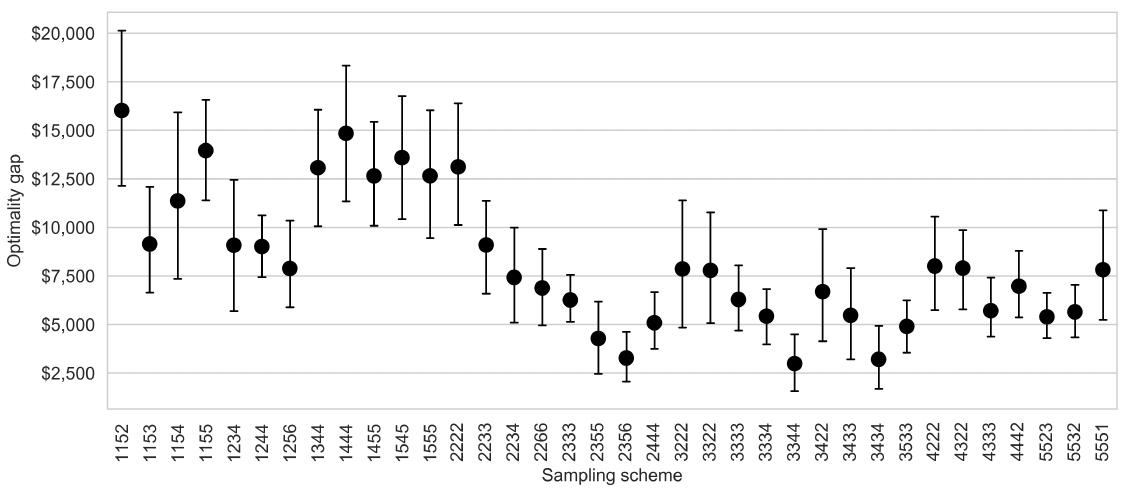
Figure 3. Change of optimality gap values due to the sample size and the configuration of the sampling scheme using severe climate change